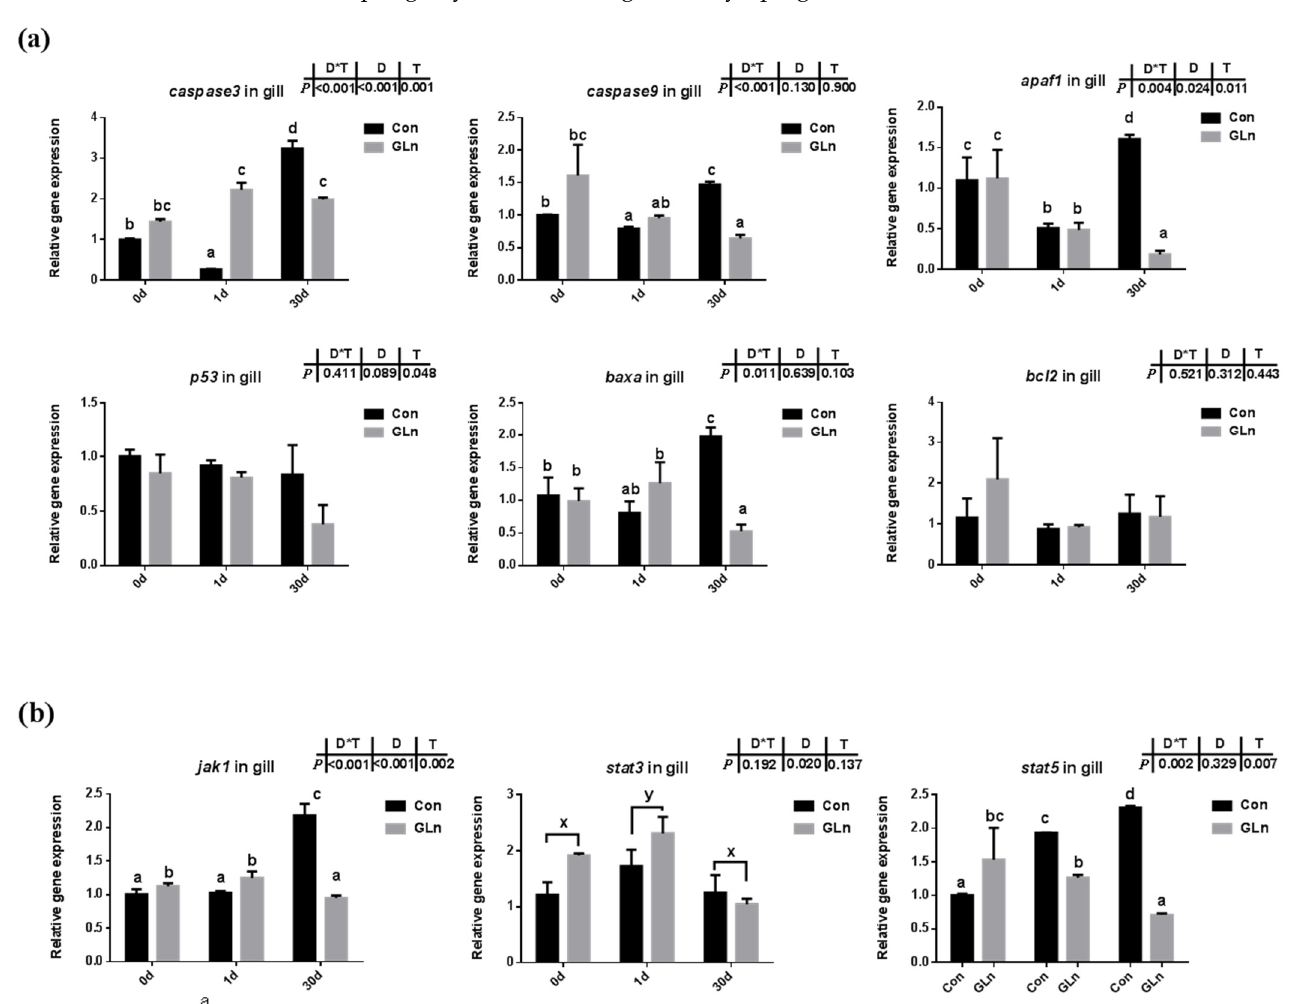
Figure 5. The effects of dietary glutamine on the apoptosis of yellow catfish during F. columnare infection along with the JAK-STAT signaling pathway. ( a ) The relative mRNA expression level of caspase-3 , caspase-9 , apaf1 , p53 , baxa , bcl2 in gill of yellow catfish in both control group (Con) and glutamine supplementation group (Gln) at 0 d, 1 d and 30 d after F. columnare infection. ( b ) The relative mRNA expression level of jak1 , stat3 , stat5 in gill of yellow catfish in all treatments. All data were analyzed with two-way ANOVA and data are means ± SD ( n = 3). When significant D*T were observed ( p < 0.05), data were analyzed by one-way ANOVA followed by Tukey’s multiple range tests to inspect differences among all the data, with “a–e” to indicate the significant difference. When the significance is only with the main effects of D or T, “a–e” and “x–z” were labeled to indicate the significant difference among groups in D or T,